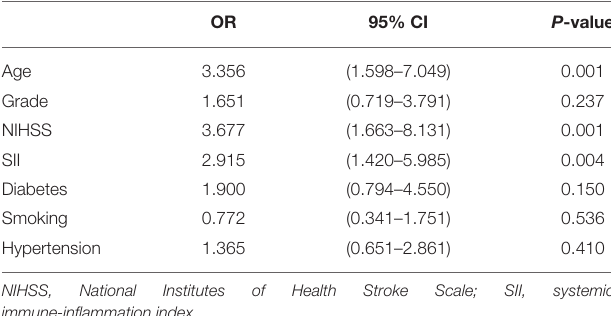
TABLE 5 | Binary logistic regression analysis predicting